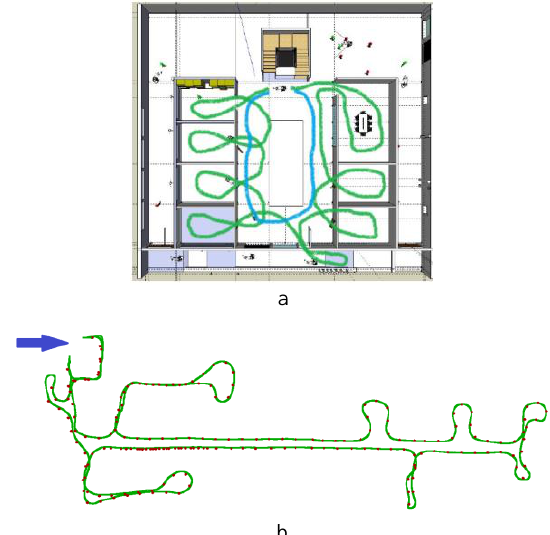
Figure 3. Sensor Trajectory; a) Ideal (closed loop) trajectory suggested by system provider (Viametris, 2017), and b) Intentional loop closure failure for simulating the possible practical situations.